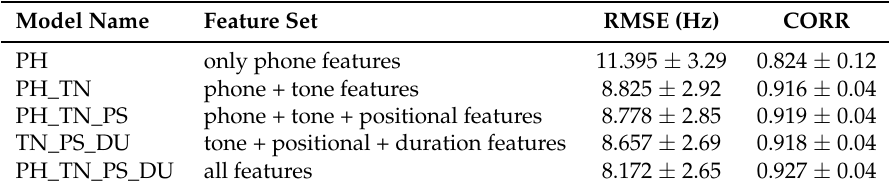
Table 5. The RMSE and correlation (CORR) of models trained by different combinations of feature sets ( ± denotes standard deviation).